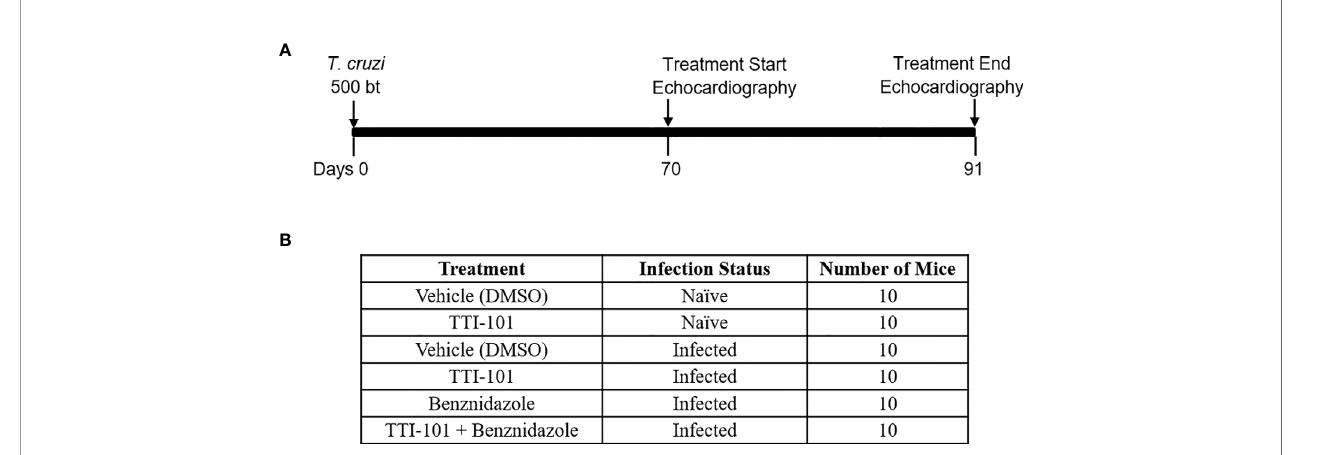
FIGURE 1 | Experimental design. Shown is the timeline for experimental infection with Trypanosoma cruzi , TTI-101 and/or benznidazole treatment, and echocardiography imaging in a mouse model of chronic Chagasic cardiomyopathy (A) . Six treatment and control groups are listed, with untreated animals receiving dimethyl sulfoxide (DMSO) treatment vehicle alone (B)